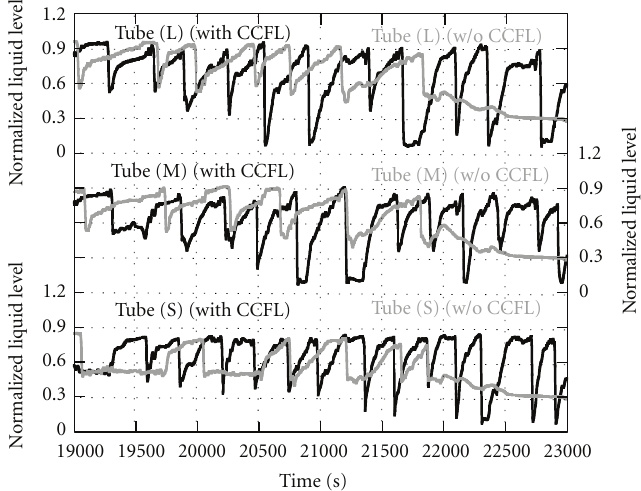
Figure 31: RELAP5 results for collapsed liquid levels in upflow side of SG U-tubes in loop with PZR in cases with or without application of Wallis CCFL correlation to inlet of